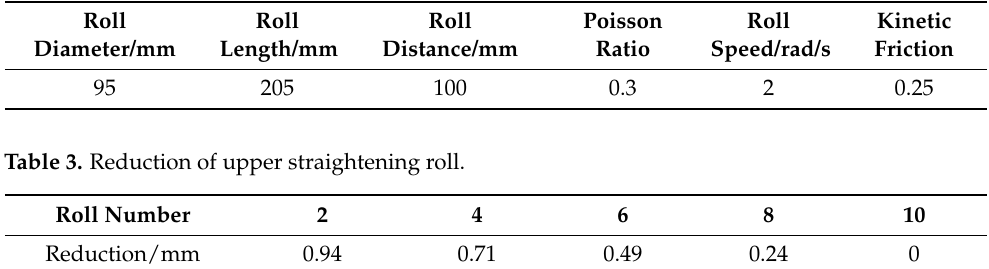
Table 2. General parameters of straightener.